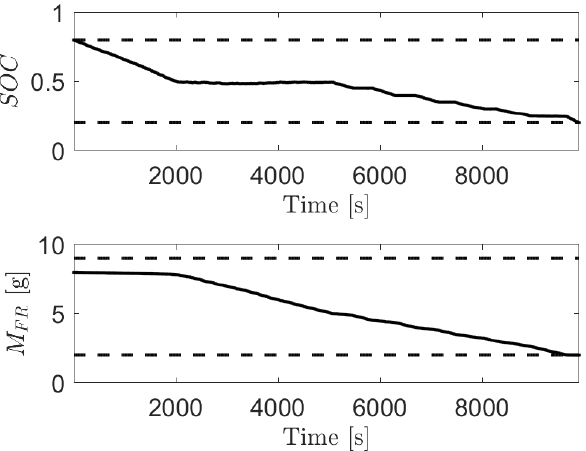
Figure 8. SOC and remaining M FR versus time, Simulation Scenario I; dashed lines show constraints.